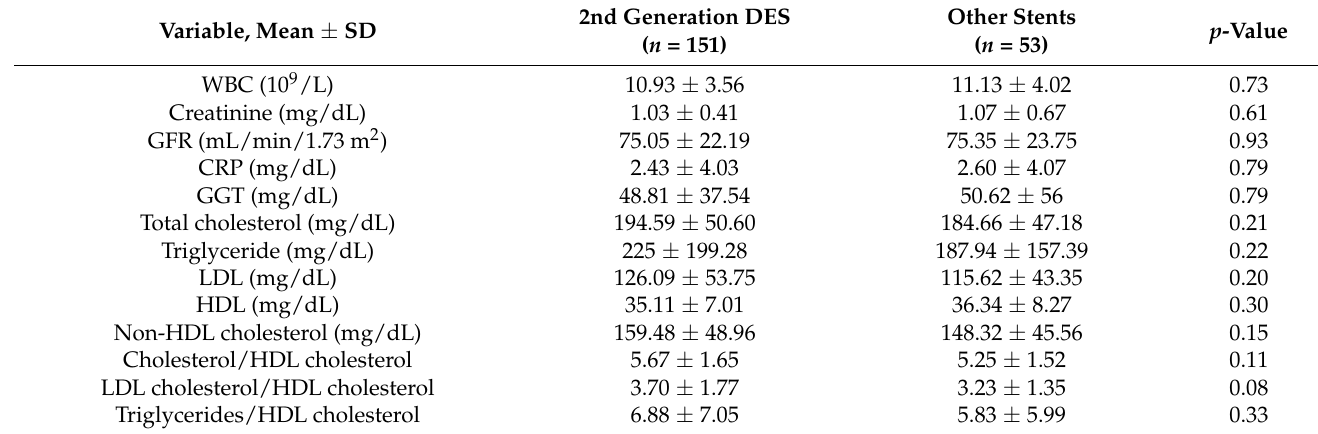
Table 4. Laboratory tests.